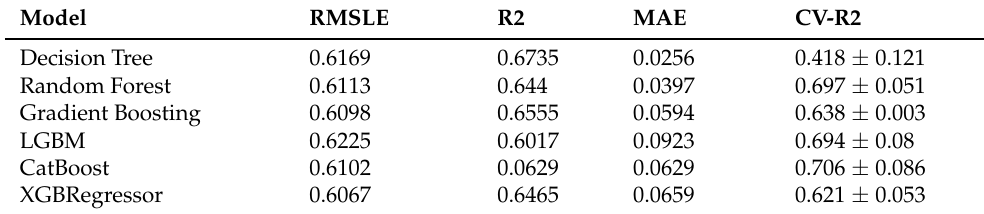
Table 8. Results of severity for the left elbow.